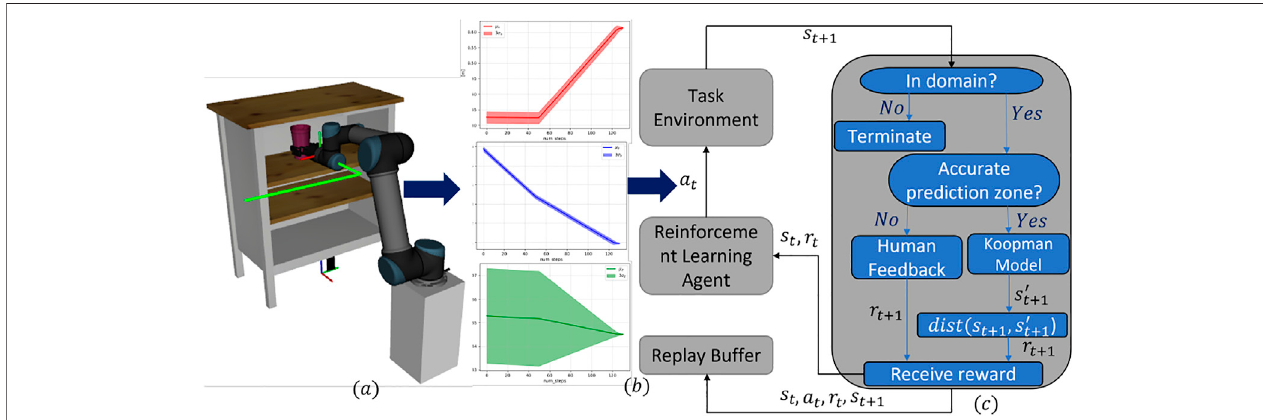
FIGURE 1 | Koopman operator – based knowledge-guided RL framework: (A) A simulated UR5 robot is executing a demonstrated trajectory to perform putting a cupinashelf task.Thedemonstratedpathisshownusingagreen fi rmline. (B) Meanandstandarddeviationsofthecomponentsofthepositionvectors,i.e., x , y , z ,ofall the way points in the demonstrated trajectories. (C) Schematic diagram of the training loop of the RL agent using the proposed methodology.